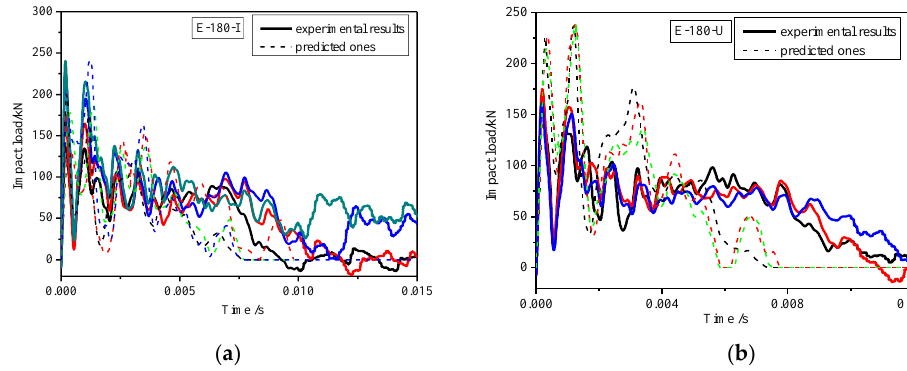
Figure 12. Impact load-time histories for the specimens ( a ) E-180-I and ( b ) E-180-U.